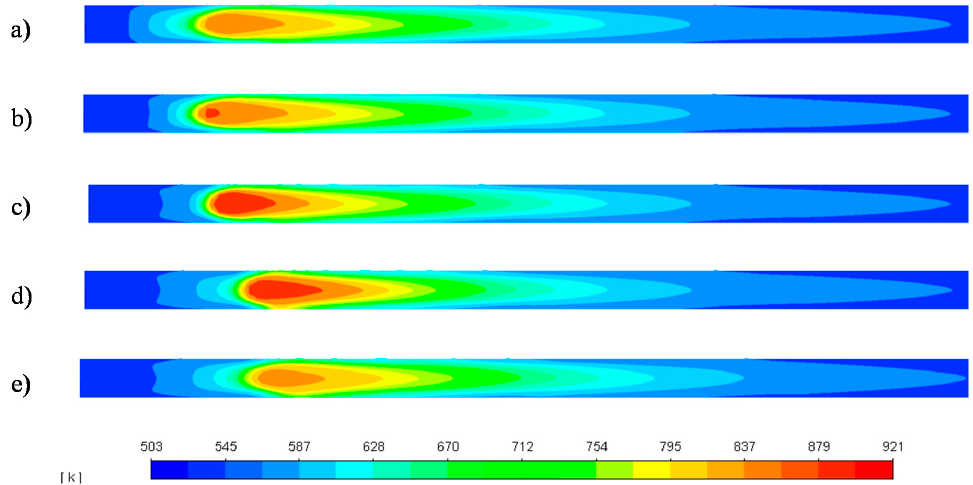
Figure 12. Temperature contours in the hot-spot relevant zone after a 20 K step-drop in the feed gas (523 K to 503 K) at t = ( a ) 10 s, ( b ) 20 s, ( c ) 30 s, ( d ) 60 s, ( e ) 200 s from the disruption.